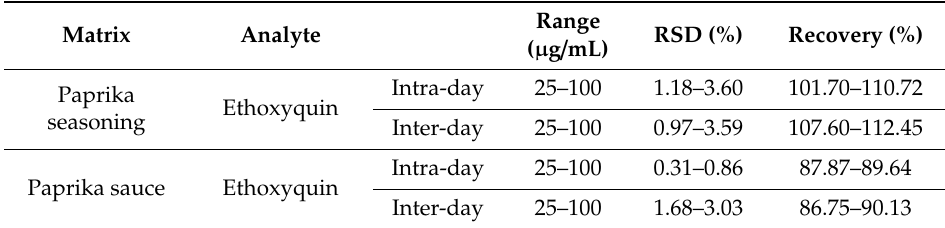
Table 3. Recoveries of spiked ethoxyquin (three di ff erent concentrations) from paprika seasoning and paprika sauce samples (n =